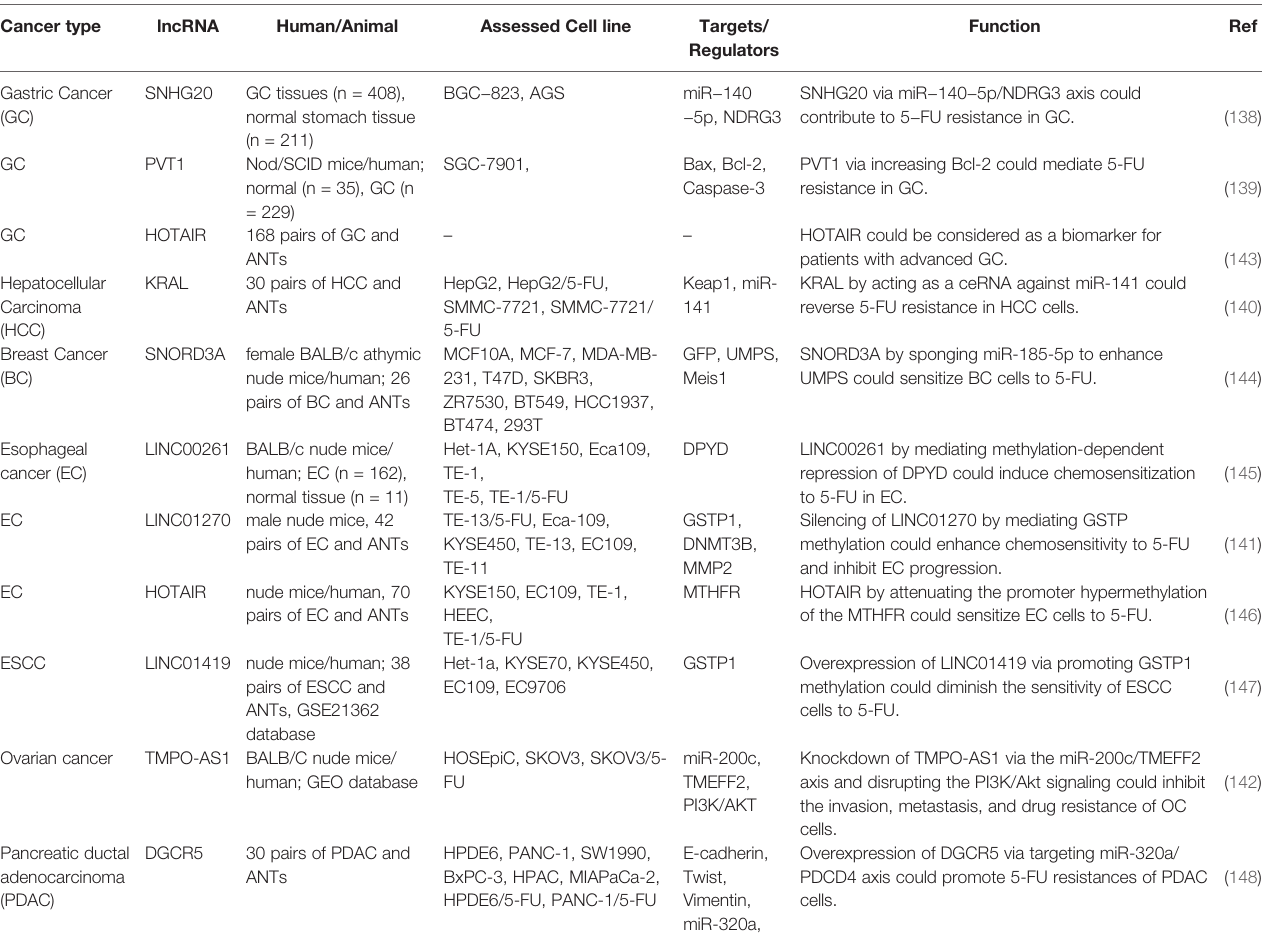
TABLE 7 | Role of lncRNAs in the modulation of response to 5-FU in other cancers (ANT, adjacent normal